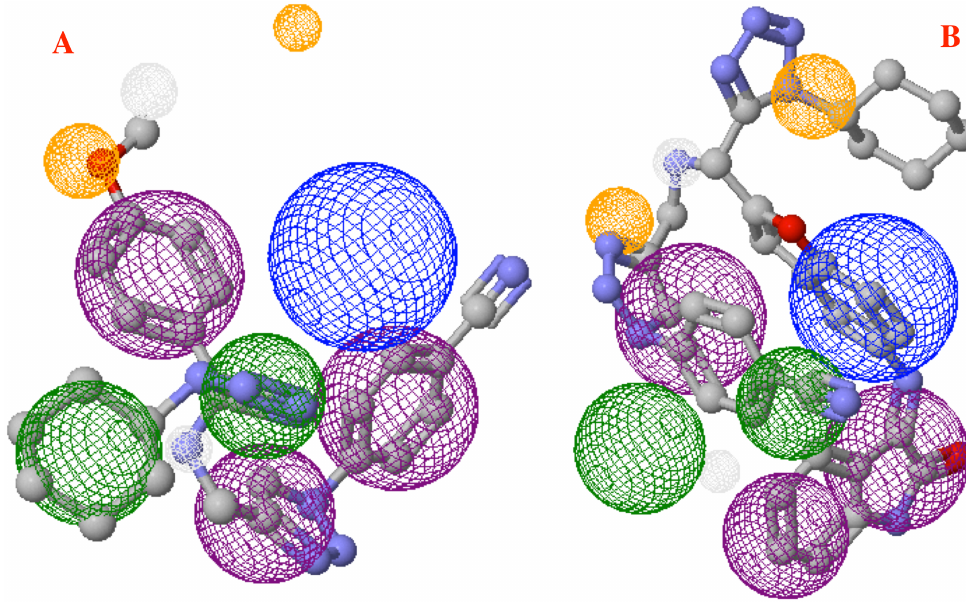
Figure 9 Main molecules overlap into the pharmacophore model for the CoV-2-M Pro protein. (A) 1e and (B) p8 molecules overlap into the pharmacophore model for the CoV-2-M Pro protein. Green spheres depict the hydrophobic segments (Hy), blue spheres are the aromatic segments (Ar), purple spheres represent the hydrophobic and aromatic segments (Hy – Ar), gray spheres depict the hydrogen donor segments (HD) and the orange sphere represents the hydrogen acceptor segments